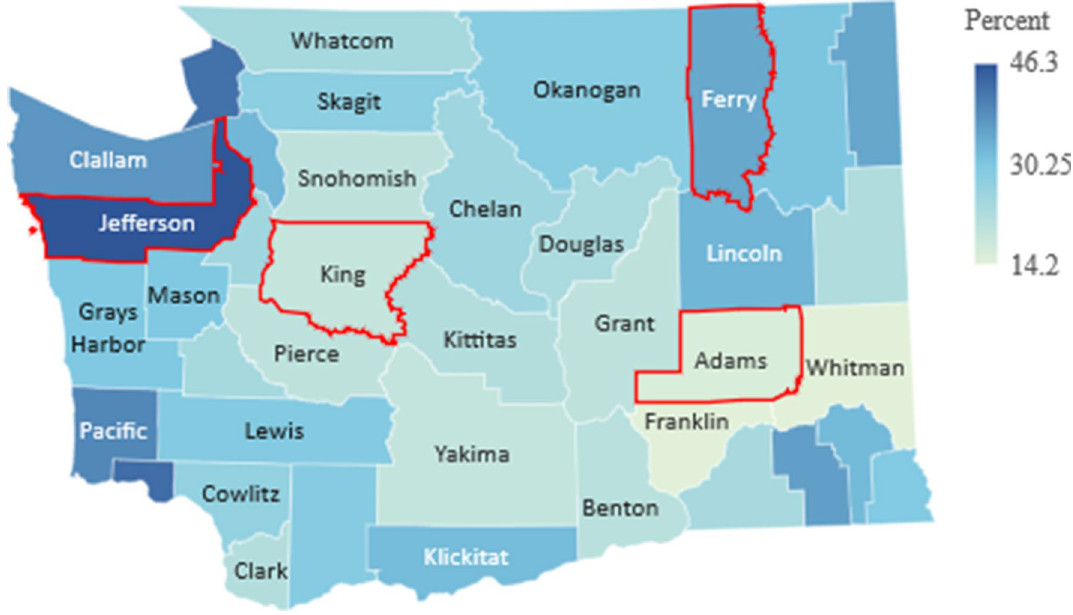
Figure 5. Percent of population over 60. Figure made with Excel using dataset in 9 .